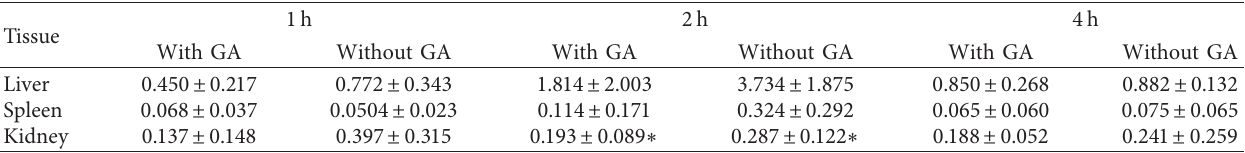
Table 5: Results of BB at a dose of 200mg/kg in tissues of rat (mean ± SD, n � 6, µ